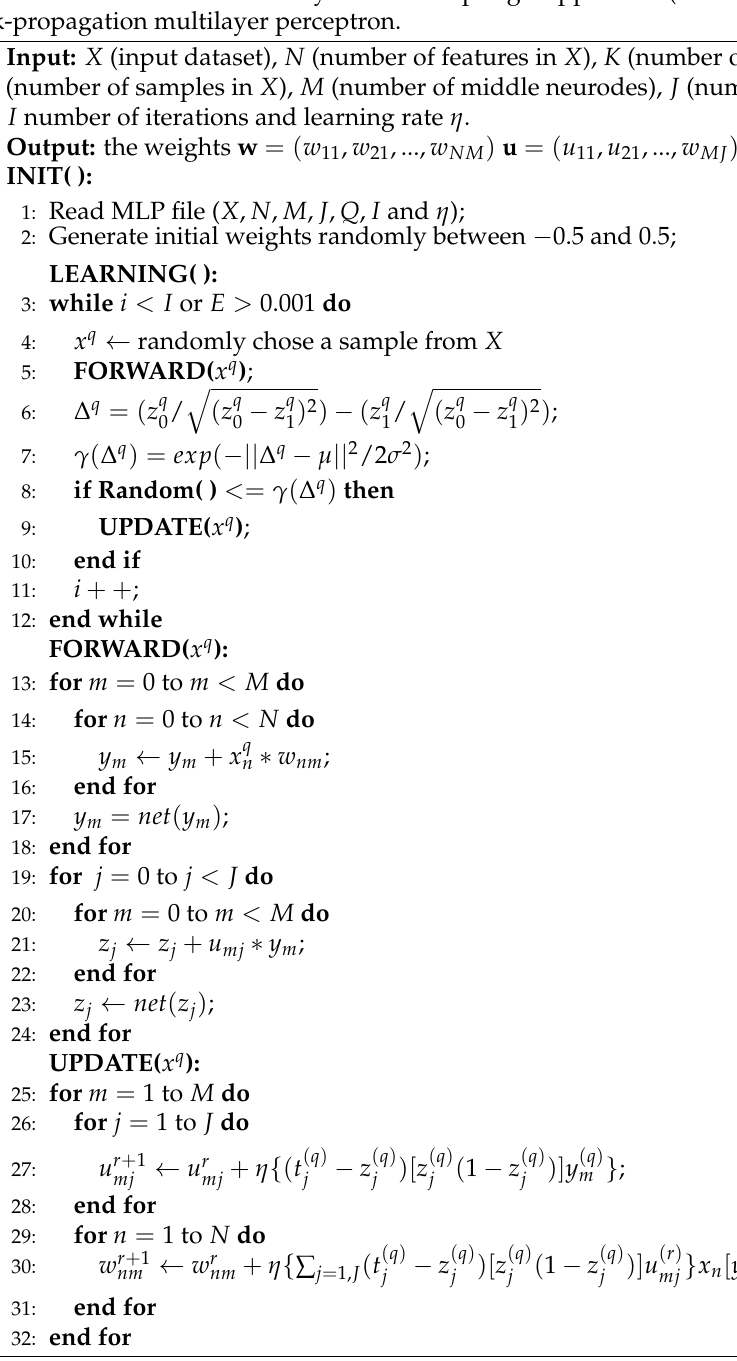
Algorithm 1 The Selective Dynamic Sampling Approach (SDSA) based on the stochastic back-propagation multilayer